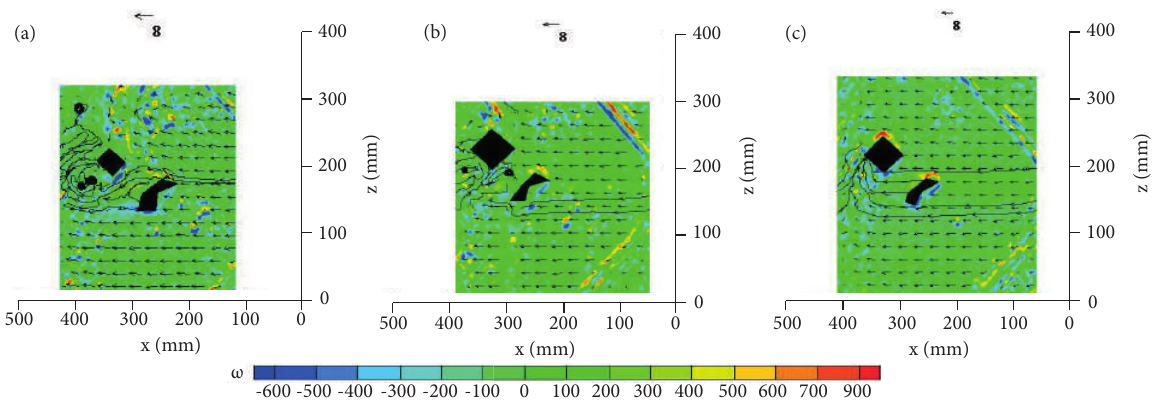
Figure 25. Vorticity contours and velocity vectors varying the height of laser plane for